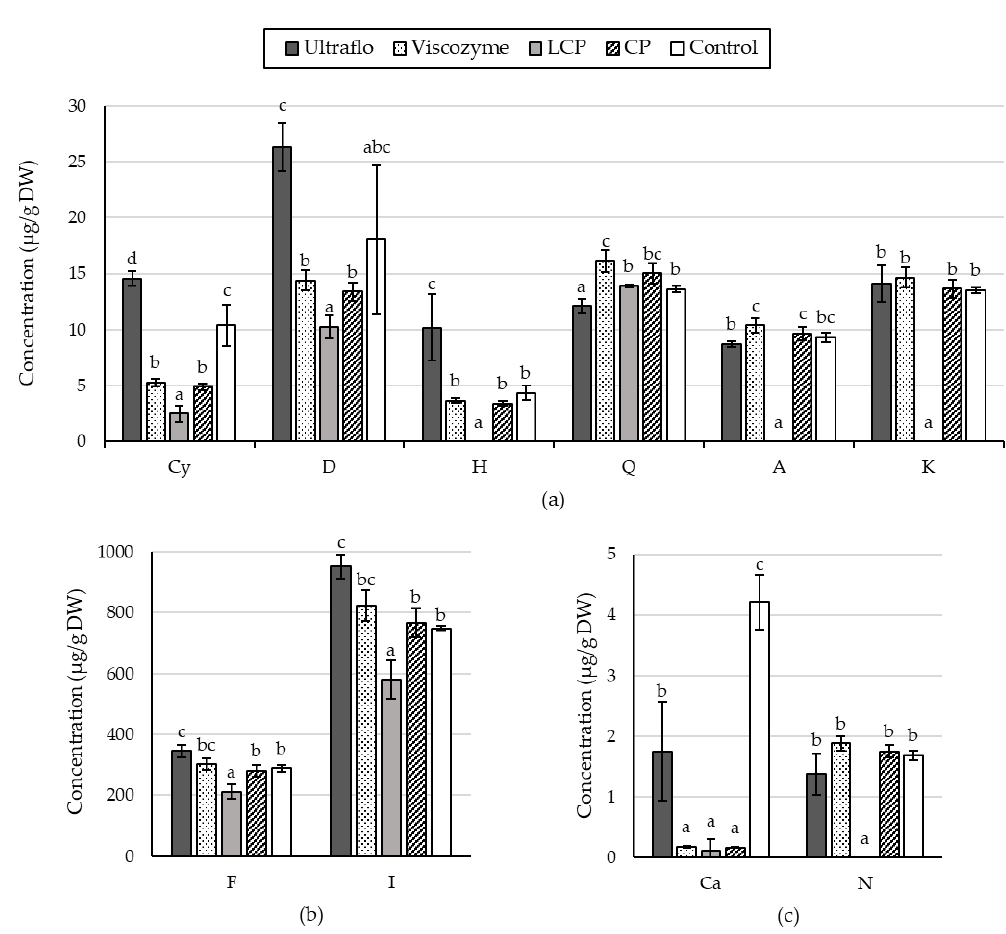
Figure 9. The antioxidant activity (AA) of the ethanolic extracts of Agave lechuguilla bagasse estimated through a DPPH radical scavenging assay after enzymatic hydrolysis conducted with two commercial cocktails (Ultraflo© and Viscozyme©), two formulated cocktails with laccase, cellulase, and pectinase at proportions of 1:1:1 (LCP) and 0:1:2 (CP), and the control treatment without enzymes. Different letters indicates statistical significance with the Kruskal–Wallis test (n = 6, p < 0.05).